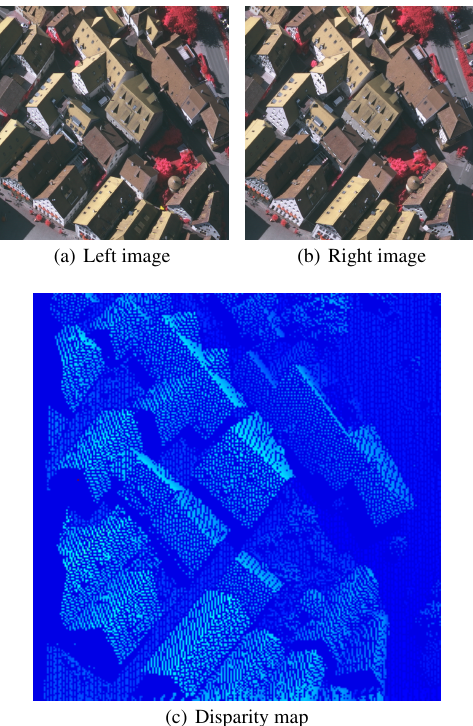
Figure 4. An example of the dataset. In Figure 4(c), pixels with valid disparity values are displayed in bright.